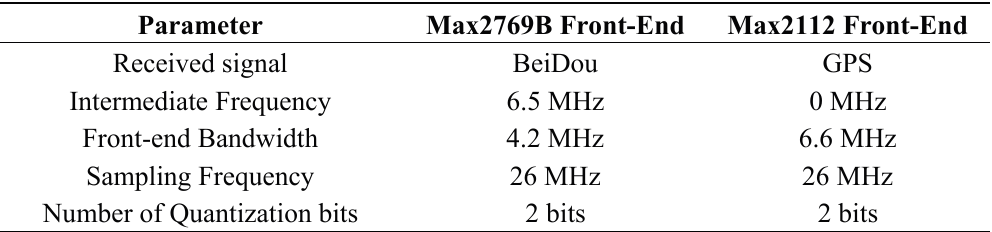
Table 2. NSL stereo v2 front-end configurations.